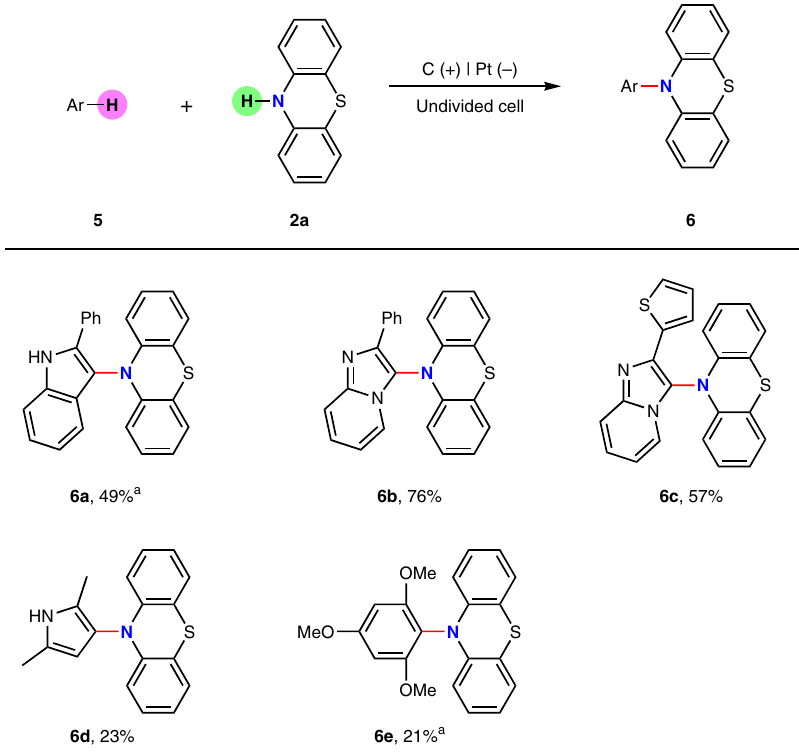
Fig. 4 C – H amination of electron-rich arenes with phenothiazine. Reaction conditions: graphite rod anode ( ϕ 6 mm), platinum plate cathode (15 mm × 15 mm × 0.3 mm), constant current = 12 mA ( J anode ≈ 13.3 mA cm − 2 ), n Bu 4 NBF 4 (0.15 mmol), 5 (0.24 mmol), 2a (0.20 mmol), MeCN/CF 3 CH 2 OH (7.0 mL/ 2.0 mL), room temperature, N 2 , 1.5 h (3.3 F). Isolated yields were shown. a MeCN/AcOH (9.0 mL/1.0